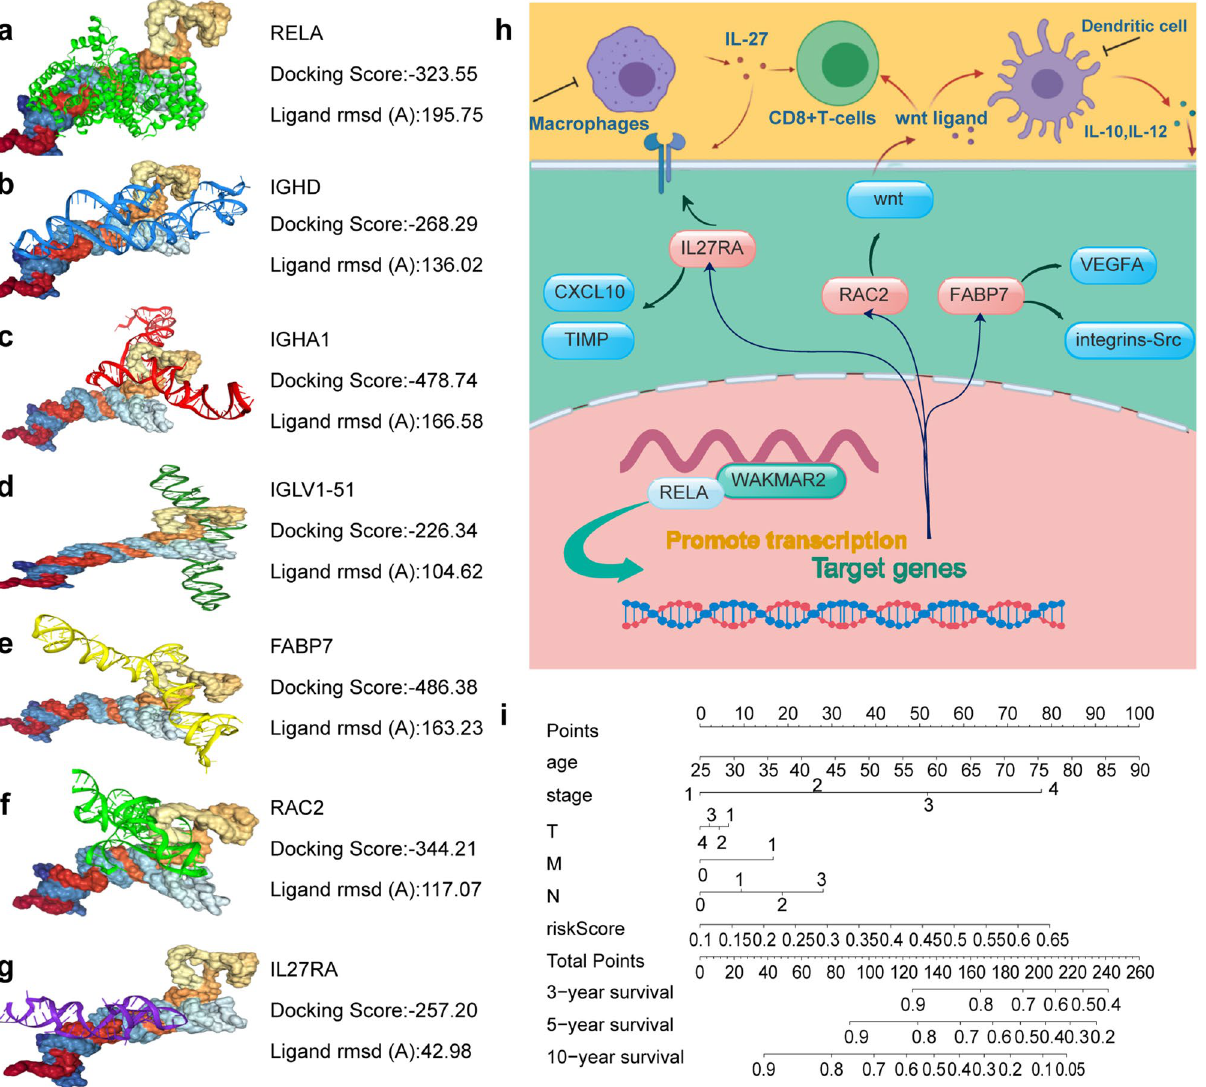
Figure 6. Molecular docking, schematic diagram, and nomogram of WAKMAR2. ( a–g ) Molecular docking of WAKMAR2 with transcription factors and immune prognostic target genes. ( h ) Schematic diagram of WAKMAR2 action mechanism. ( i ) A prognostic nomogram predicting 3-, 5-, and 10-year overall survival with breast cancer. () ChIP-qPCR analysis of RELA binding to the according region of FABP7, IGHA1, RAC2 in MB231 cells transfected with control or si-WAKMAR2. Immunoprecipitated DNAs were detected by real-time ach adenocarcinoma (STAD), and thyoma (THYM) (Fig. 8a–h). The tumour mutational burden (TMB) level is associated with sensitivity to inhibitors of immune checkpoint 17,18 . We found that the expression of WAKMAR2 in other cancers, including ACC, THCA (Thyroid Cancer), STAD (stomach adenocarcinoma), PRAD (pros- tate adenocarcinoma), PCPG (paraganglioma), PAAD (Pancreatic adenocarcinoma), OV (Ovarian carcinoma), LUSC (Lung squamous carcinoma), LUAD (lung adenocarcinoma), LIHC (hepatocellular carcinoma), LGG (low-grade glioma), KIRC (Kidney renal clear cell carcinoma), HNSC (head and neck squamous cell carci- noma), and ESCA (Esophageal carcinoma), was correlated with TMB, while in BRCA (Breast Invasive Carci- noma), THCA (thyroid carcinoma), STAD (stomach adenocarcinoma), READ (rectum adenocarcinoma), KIRC (Kidney renal clear cell carcinoma), ESCA (Esophageal carcinoma), and DLBC (diffuse large B cell lymphoma), its expression was correlated with microsatellite instability (MSI) (Fig. 7f, g). Finally, using the Oncomine data- base, we compared the transcription levels of prognostic target genes in cancer and normal samples at the pan- cancer level (Fig. 8i).